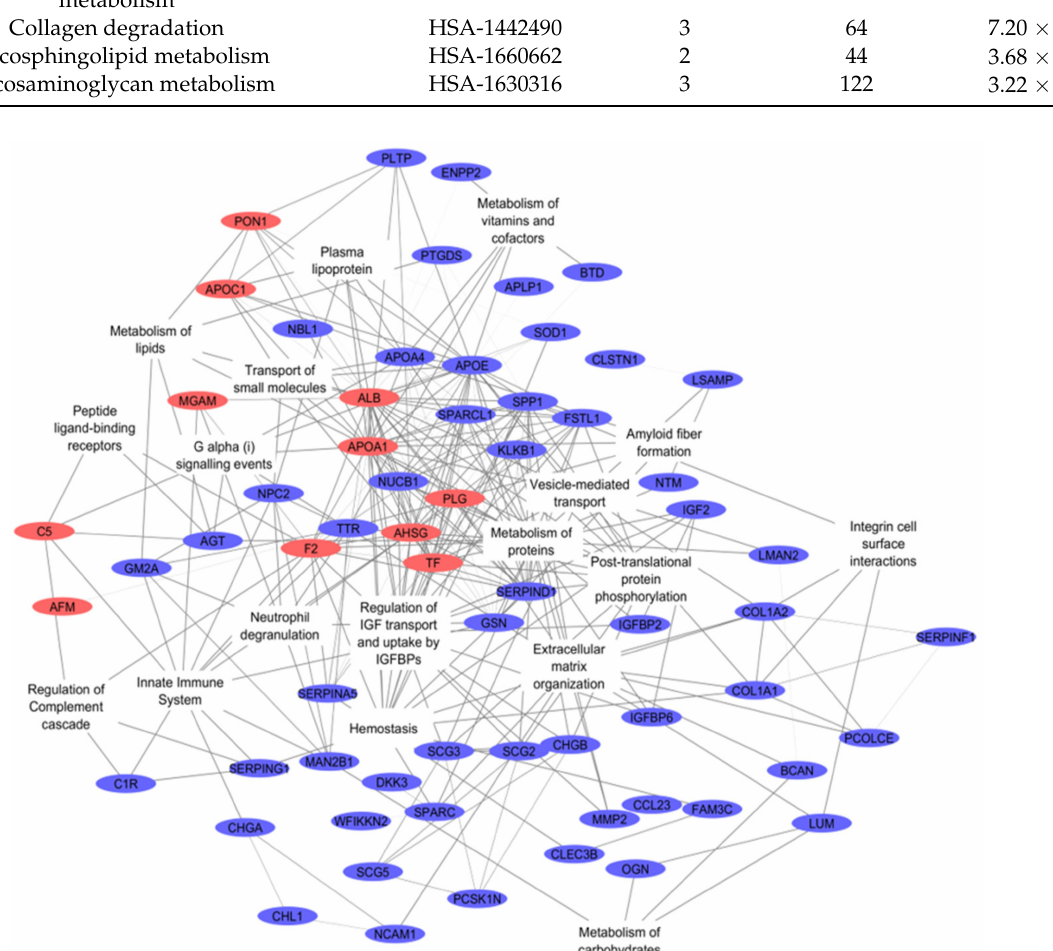
Figure 2. Interactome of pathways differentially expressed between control and intervertebral disc herniation (IVDH) groups and their intermediate proteins. The network was visualized using the Cytoscape using the results of REACTOME pathway analysis and protein-protein interactions identified with STRINGdb. Proteins overexpressed in IVDH are in red, lower-expressed are in